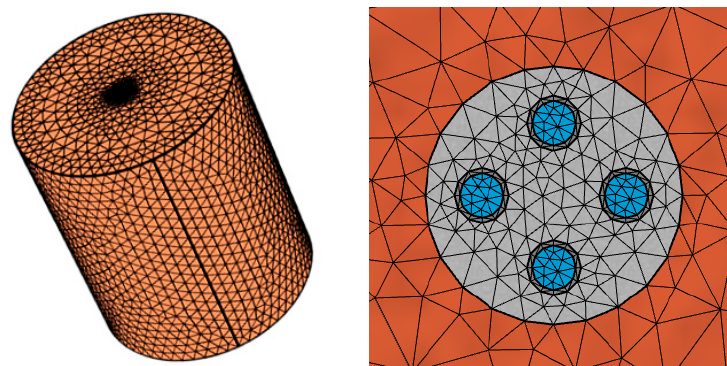
Figure 3. Illustration of the mesh employed for the whole computational domain ( left ) and the particular mesh of the borehole top ( right ).